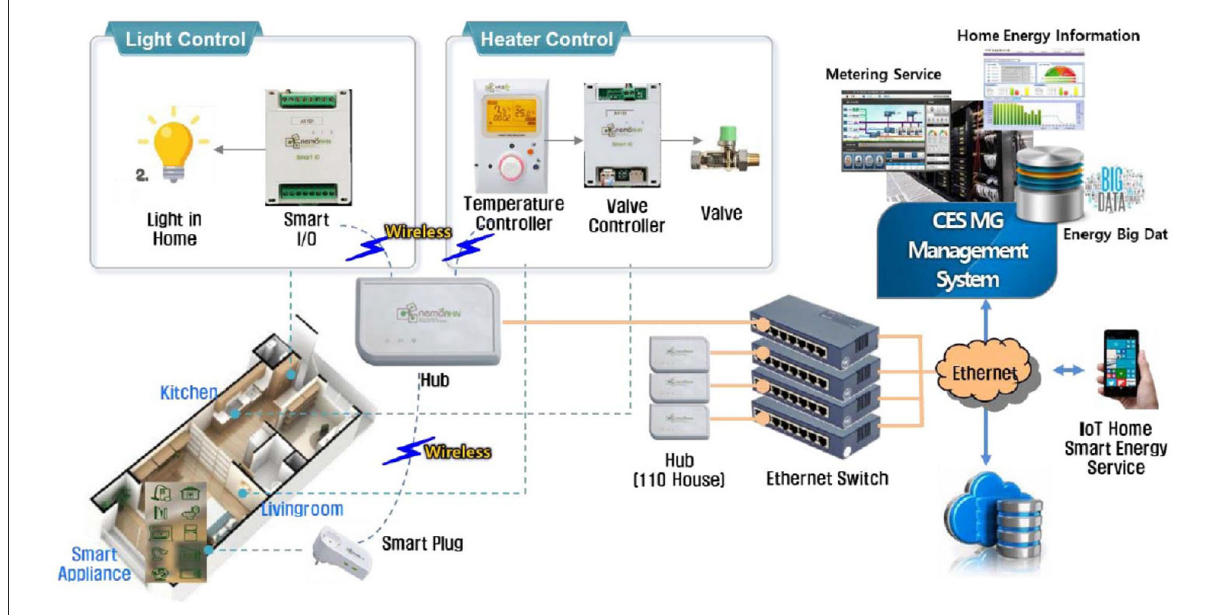
FIGURE10 Proposed architecture of IoT energy management gateway (Ku et al., 2017).